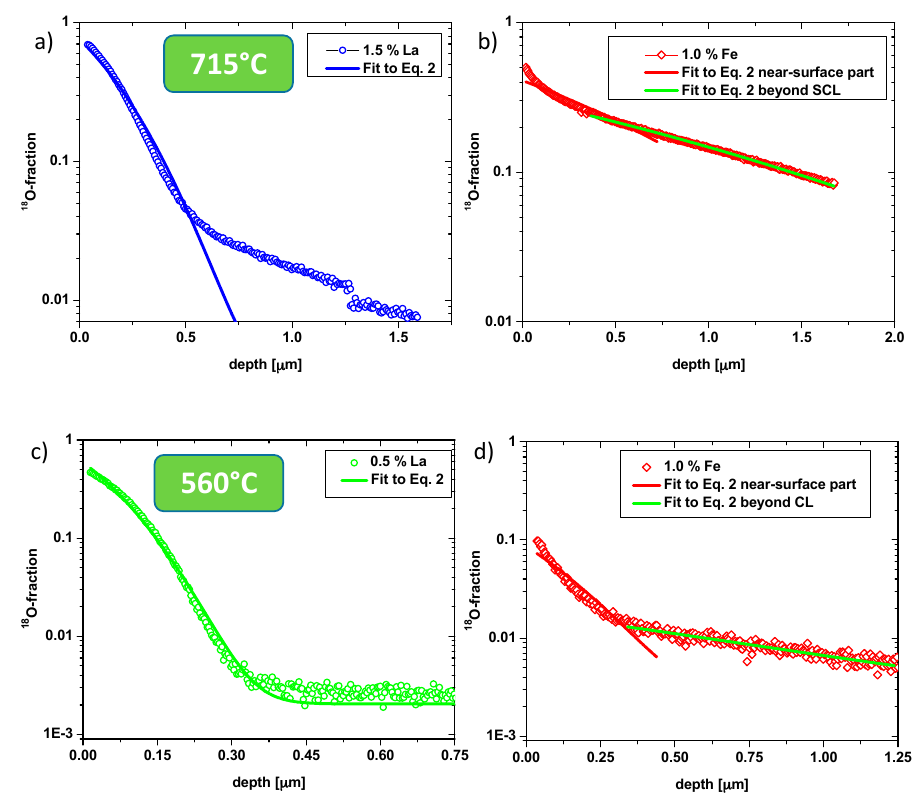
Figure 3. ( a ) Tracer depth profile of 1.5% La-doped PZT at 715 °C with fit according to Equation (2). A clear grain boundary contribution is indicated by the diffusion tail. ( b ) Tracer depth profile of 1% Fe-doped PZT at 715 °C with fits according to Equation (2) in the near surface regime and in the region in some depth (beyond SCL = space charge layer); ( c ) tracer depth profile of 0.5% La-doped PZT at 560 °C with fit according to Equation (2); ( d ) tracer depth profile of 1% Fe-doped PZT at 560 °C with fits according to Equation (2) in the near surface regime and in the region in some depth (beyond SCL).